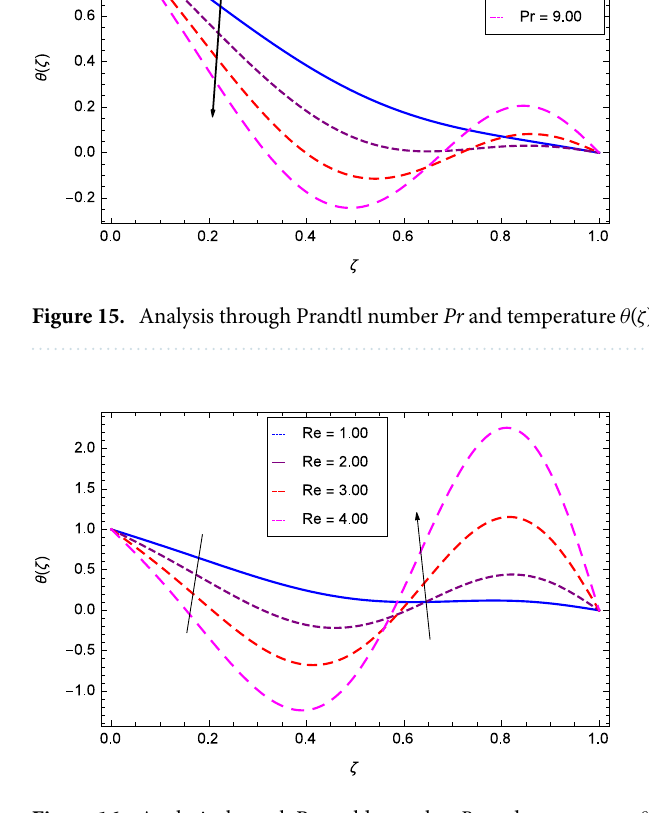
Figure 16. Analysis through Reynolds number Re and temperature θ ( ζ ).